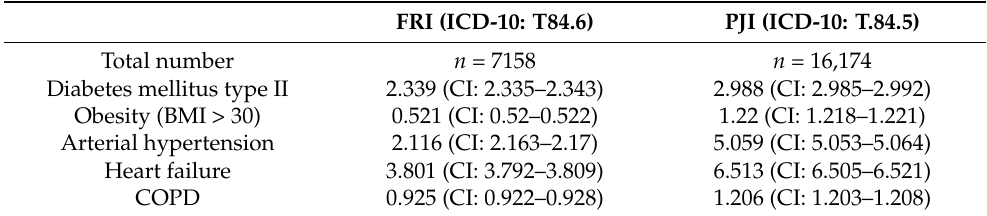
Table 2. Relative Risk and associated confidence interval (CI) of specific comorbidities compared to the general population (older than 20 years in the year 2019).